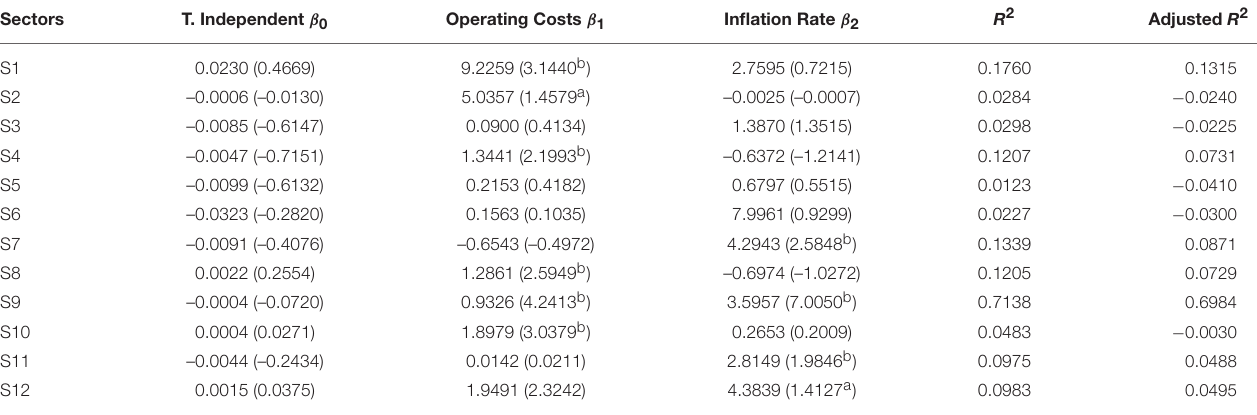
TABLE 2 | Estimation of FT coefficients with “operating costs” variable.